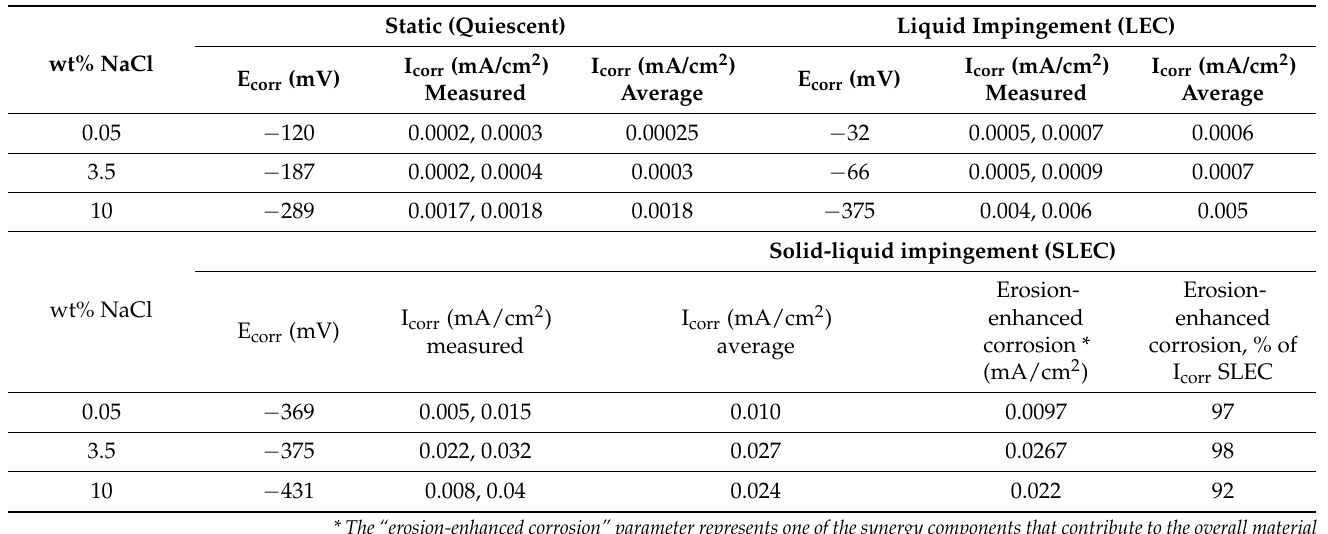
Table 3. Influence of salinity on corrosion rates of UNS S31600 steel in the different hydrodynamic